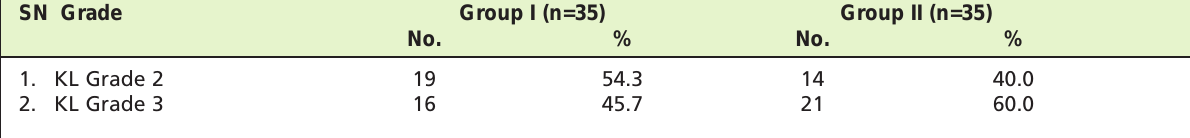
Comparison of two groups according to Pre-intervention KL Grade Table II: